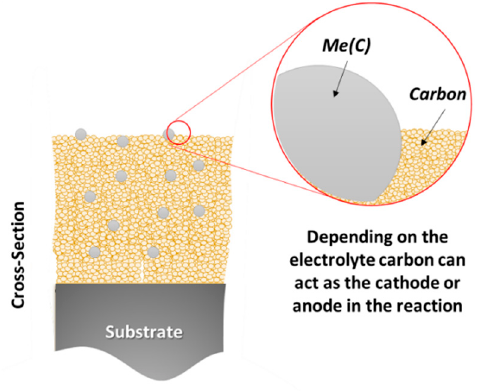
Figure 2. Schematic galvanic couples formed between carbon and metals embedded in the matrix.